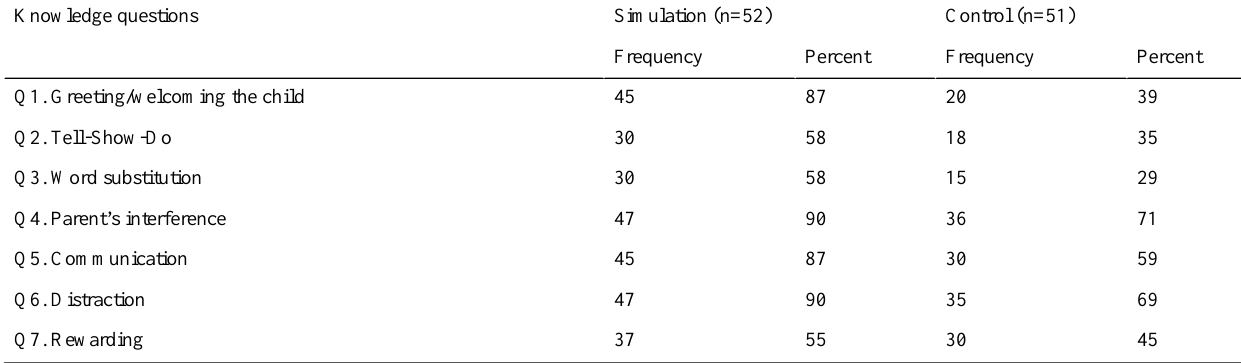
Table 3. Correct answers count per question in knowledge